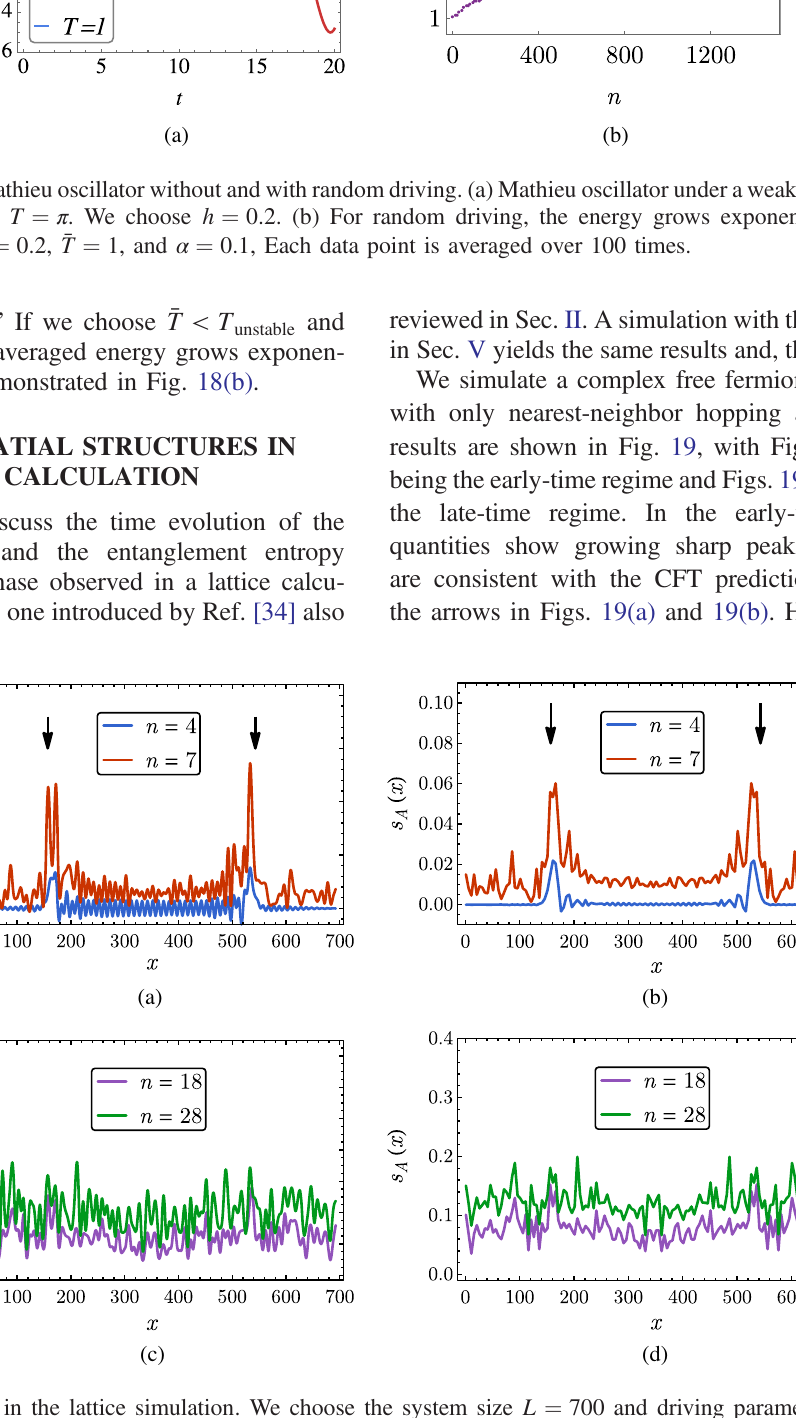
FIG. 19. Spatial structure in the lattice simulation. We choose the system size L ¼ 700 and driving parameters T 0 =L ¼ 0 . 9 and T 1 =L ¼ 0 . 2 . We choose δ ¼ 5 when performing the average. n denotes the number of driving cycles. The black arrows in (a) and (b) indicate the peak positions predicted by the CFT calculation. (a) Energy density at early time, (b) Entropy density at early time, (c) Energy density at late time, and (d) Entropy density at late